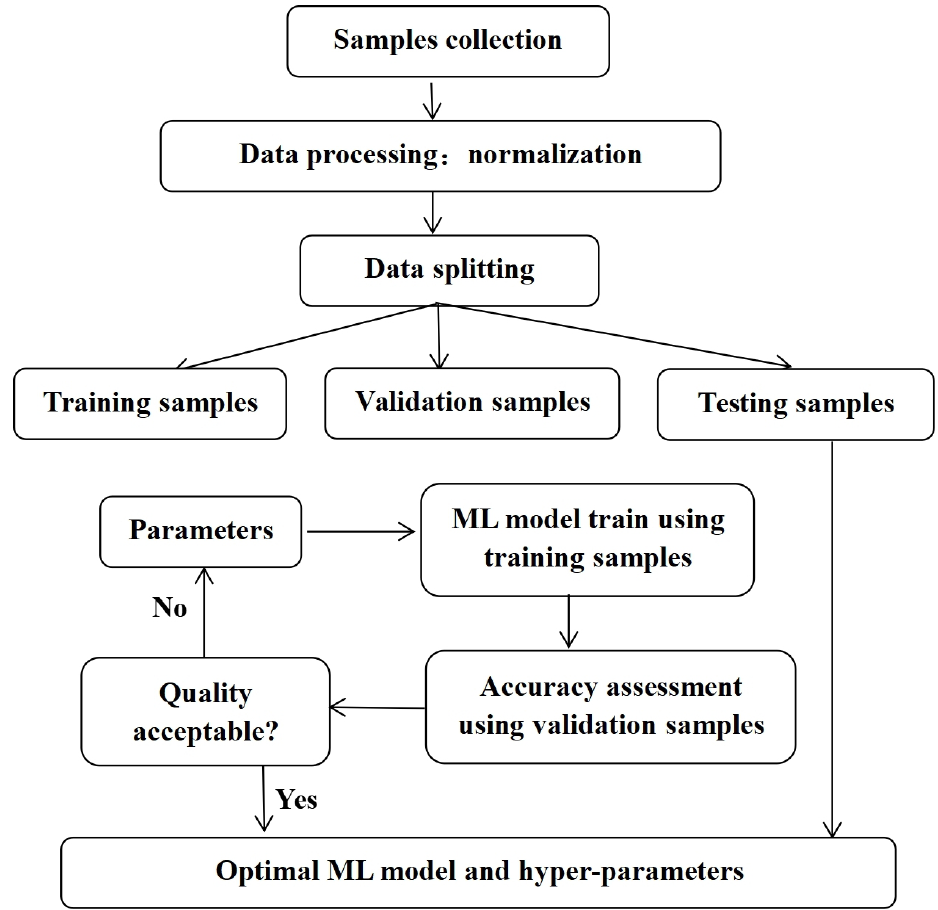
Figure 4. Illustration of whole process related to the model training, hyper-parameter optimization and accuracy